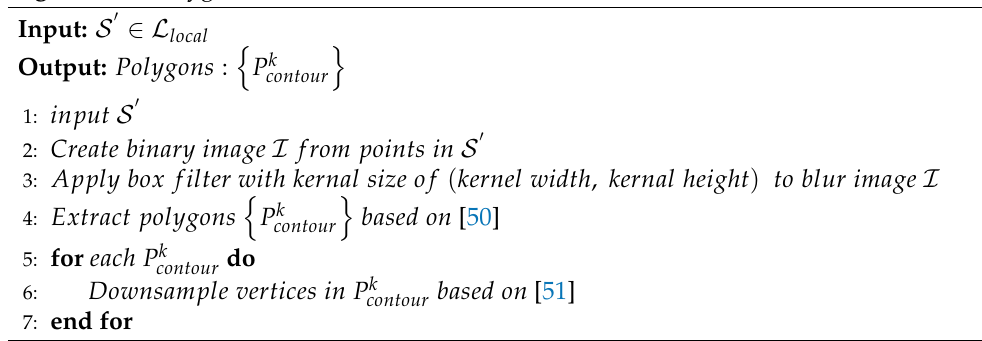
Algorithm 2 Polygon Extraction.